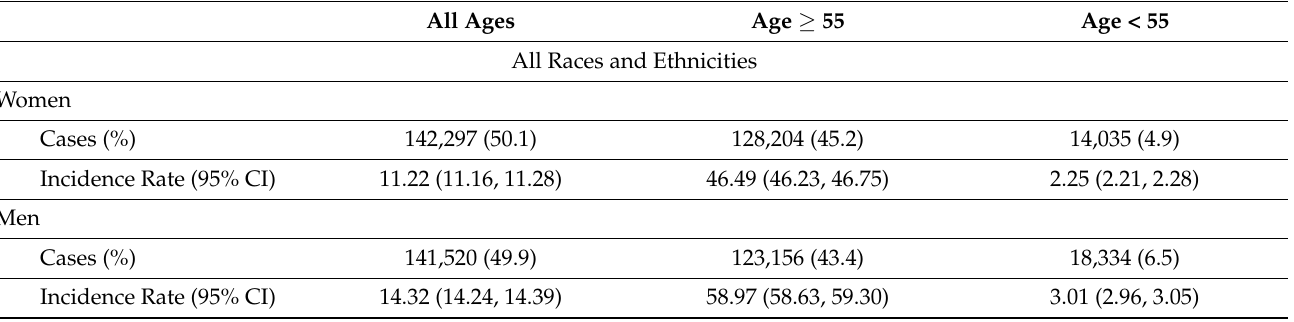
Table 1. Summary of age-adjusted pancreatic cancer incidence rates per 100,000 people stratified by age, sex, race and